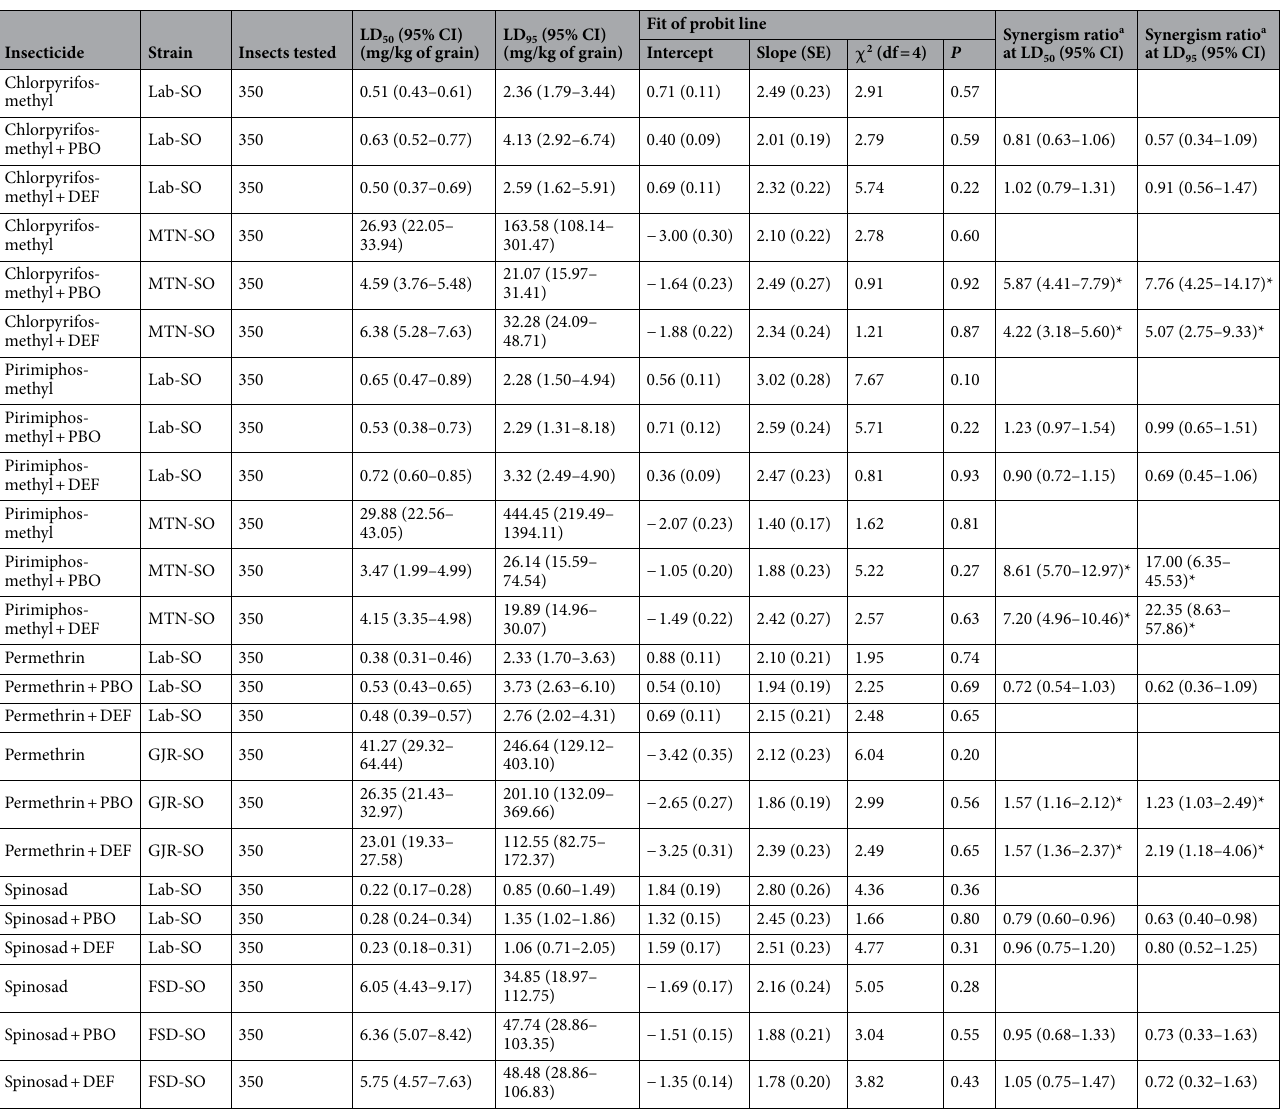
Table 2. Synergism of insecticides toxicity in laboratory and field strains of Sitophilus oryzae. a Synergism ratio was calculated by dividing the LD 50 or LD 95 of a strain tested with insecticide (Chlorpyrifos-methyl, Pirimiphos-methyl, permethrin or spinosad) alone by the LD 50 or LD 95 of the strain tested with insecticide (Chlorpyrifos-methyl, Pirimiphos-methyl, permethrin or spinosad) in combination of either PBO or DEF. *Significant synergism ratio based on the ratio test, i.e., 95% CI of the ratio did not include 1 32